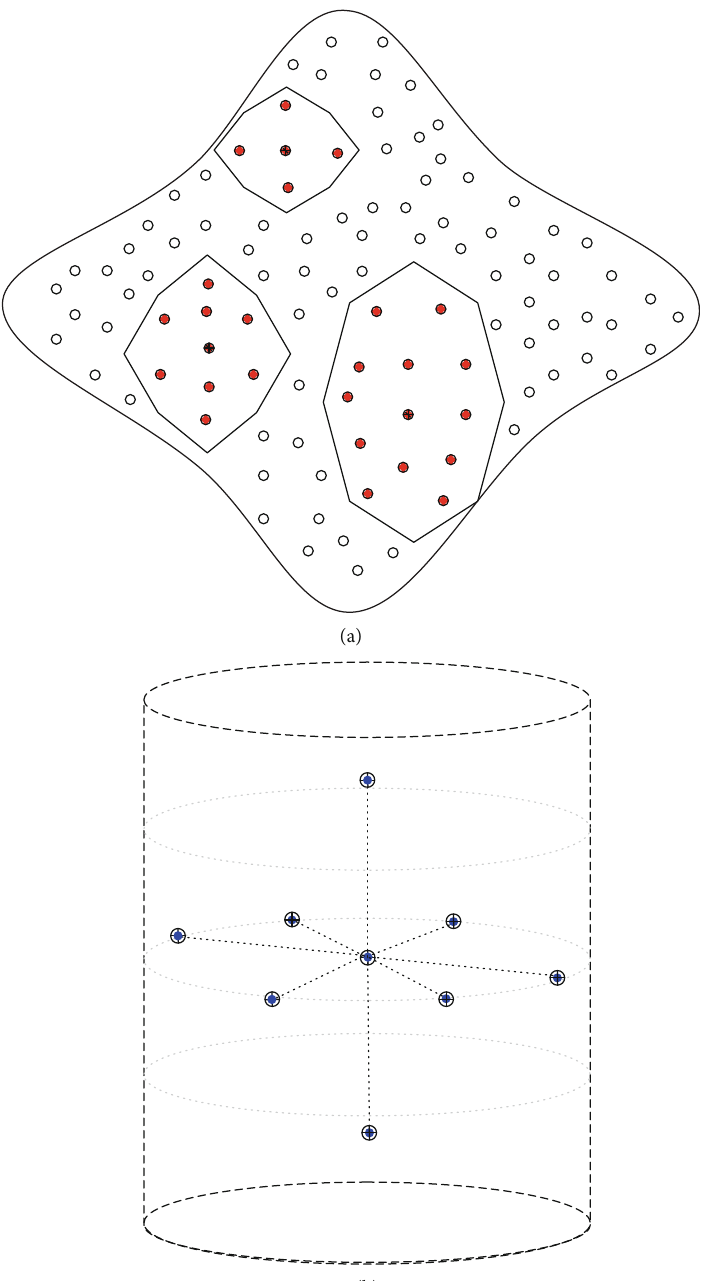
Figure 4: Schematicshowingthe fi ve-node,nine-node,andthirteen-nodelocaldomains Ω